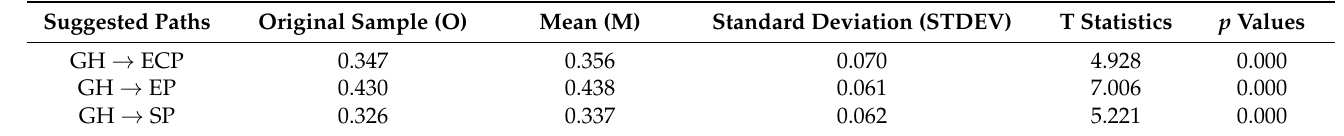
Table 5. Significance of path coefficients.